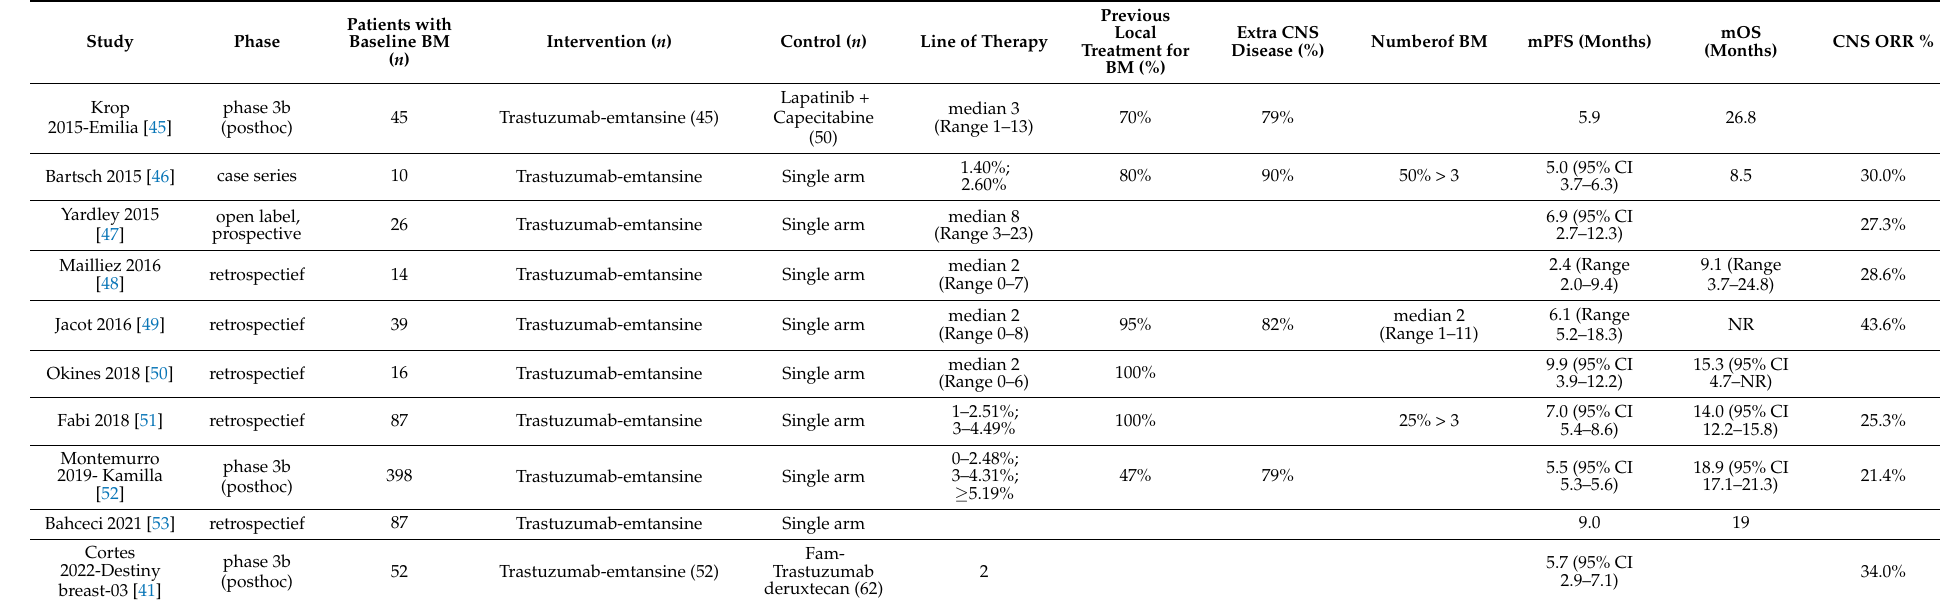
Table 2. Characteristics of included Trastuzumab-emtansine (T-DM1) studies (n =